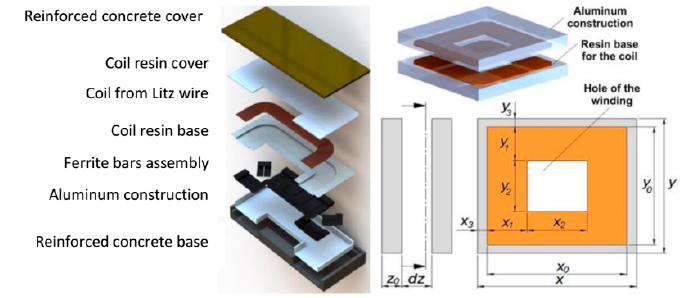
Figure 2. A 3D model of IPT coils.